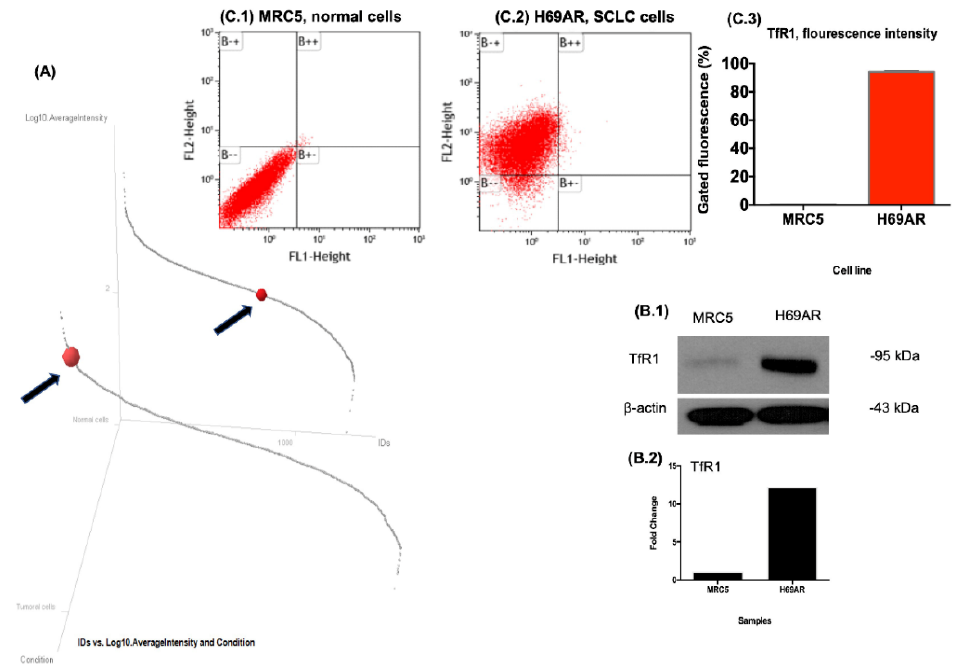
Figure 3. Expression analysis of TfR1. ( A ) Dynamic ranges of H69AR and MRC5 cells show the position of the TfR1 protein; in tumor cells (foreground), TfR1 is ranked at number 15, while in normal cells (background), it is ranked at number 725. The difference in abundance was ~33-fold change (H69AR/MRC5) ( B.1 ) Western blot analysis, indicating that the transferrin receptor was highly up-regulated in the H69AR cell line, presenting a change ten times more compared with the normal lung cell line ( B.2 ). ( C.1 ) Flow cytometry plots and the graphs of the fluorescence indicating a TfR1/TFRC signal (B − +) in a 90% gated ( C.2 ). (B − : double negative signal, B − +: single positive signal (PE), B++: double positive signal (PE and AF488), B+ − : single positive signal (AF488)). ( C.3 ) Fluorescence intensity graph, in MRC5 and H69R cells.